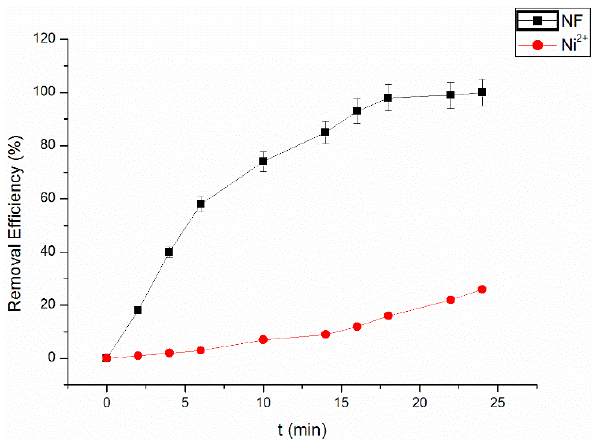
Figure 6. Comparison of Fenton catalysis with Ni 2+ alone for removal efficiency.